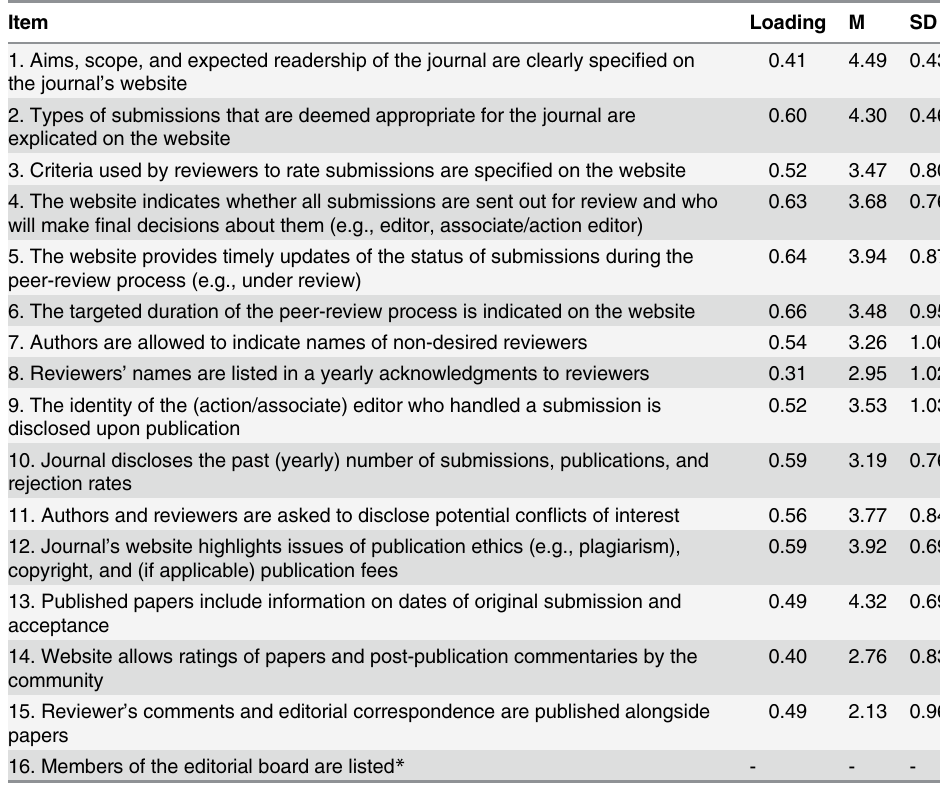
Table 2. Descriptive statistics for items in the original tool in the survey among 235 authors in 92 jour- nals (Study 1).